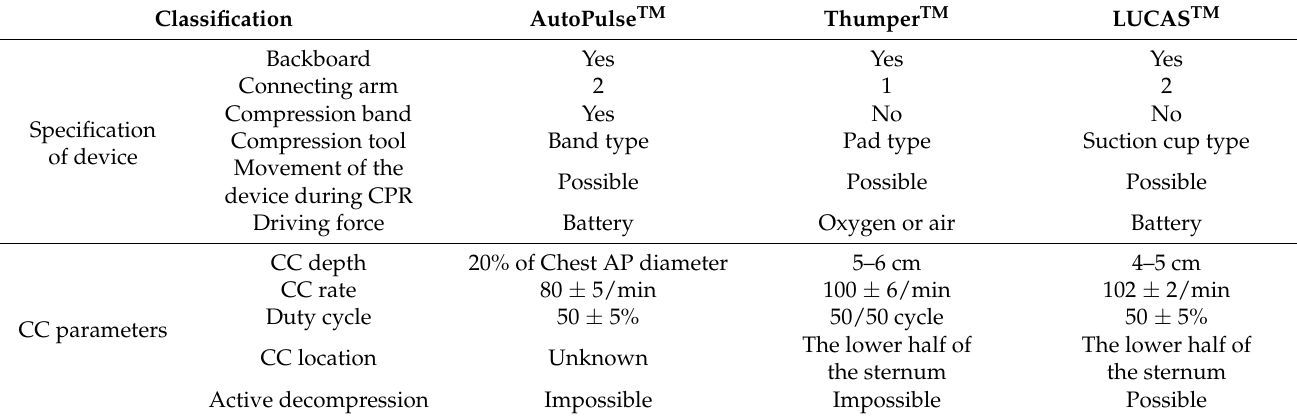
Table 1. Comparison of the compression mechanism in three different mechanical CPR devices.